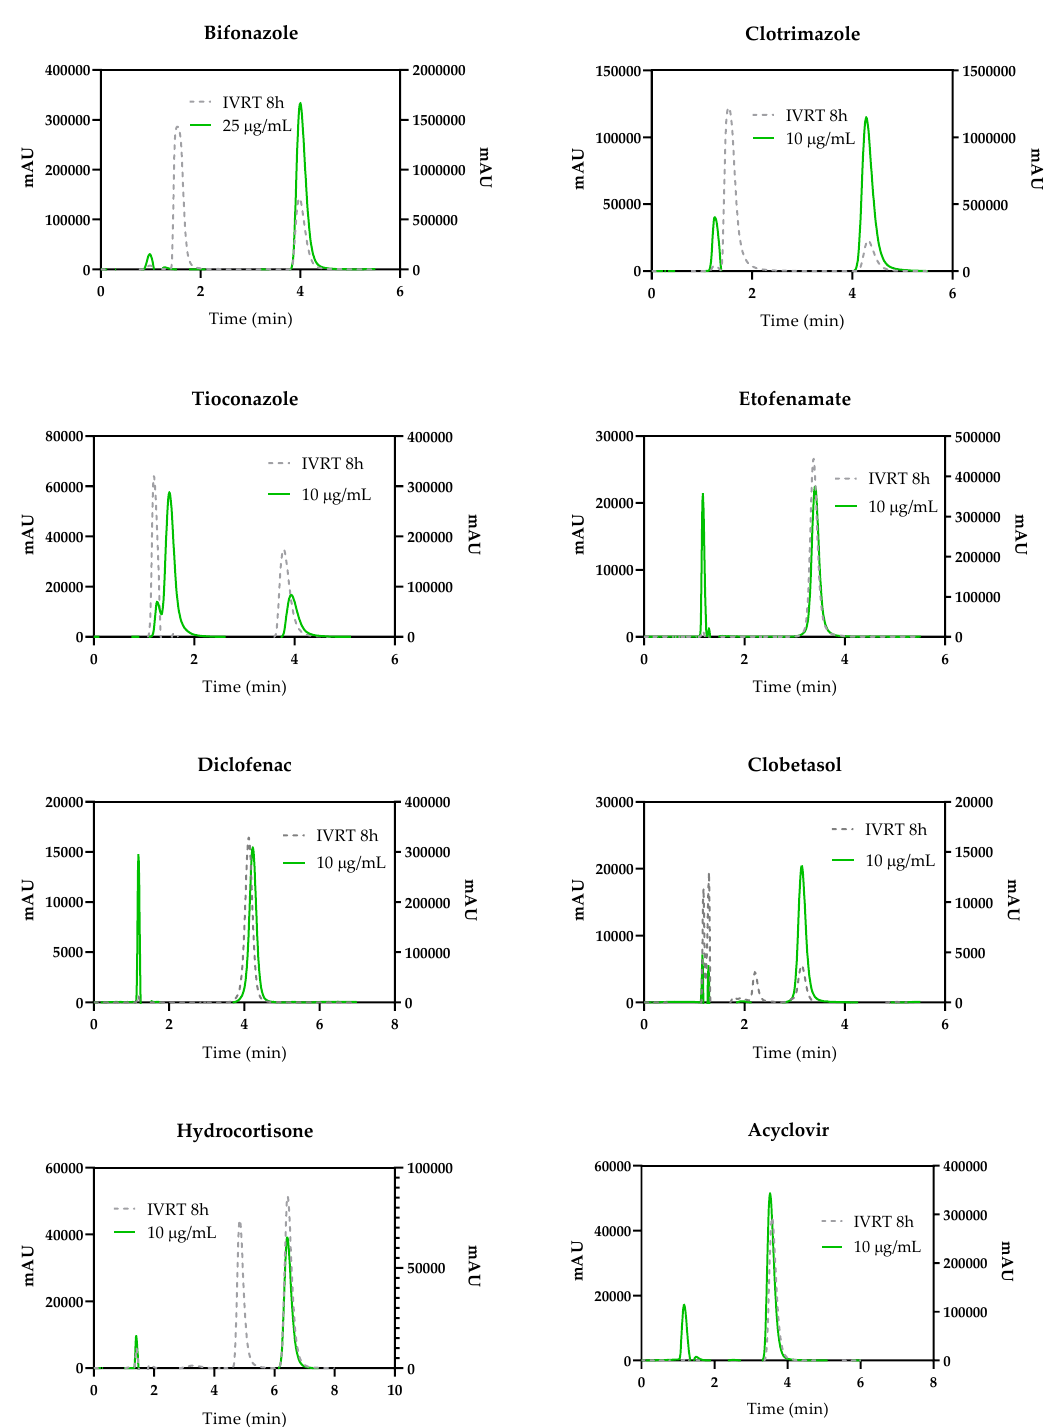
Figure 1. Representative chromatograms of a standard solution (solid green line) and in vitro release testing (IVRT) samples acquired at 8 h (dashed grey line).